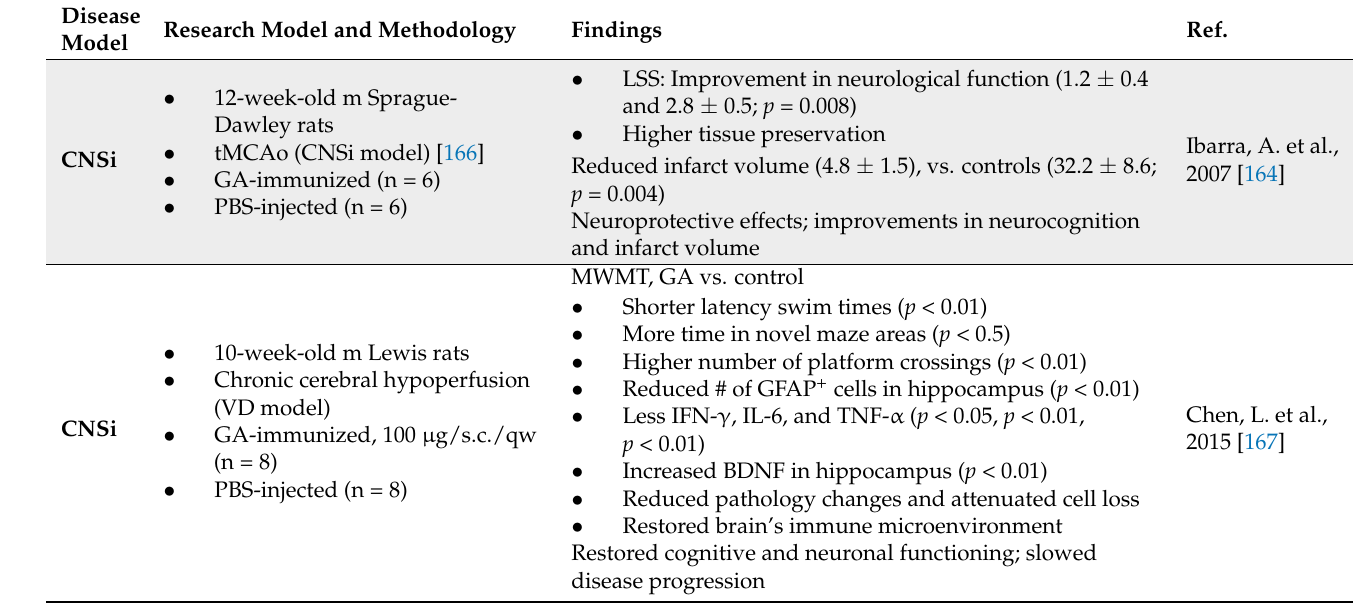
Table 10. Animal Studies Examining Alternative Uses of Glatiramer Acetate in Vascular Dementia and Central Nervous System